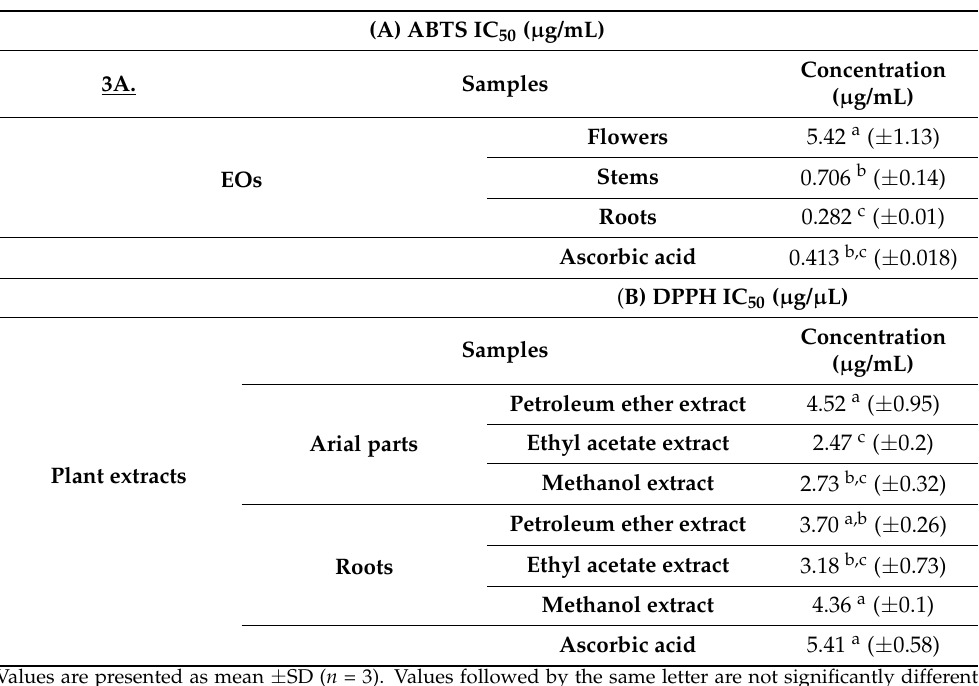
Table 3. Antioxidant activity evaluated by ABTS for the EOs (A) and DPPH test assays of plant extracts of D. triradiata samples